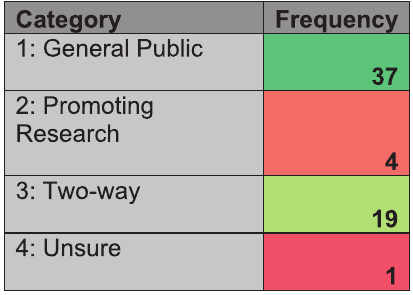
Figure 5. Major categories for ‘how knowledge exchange is related to outreach, public engagement and widening participation?’ and frequencies; listed in alphabetical order and colour coded according to